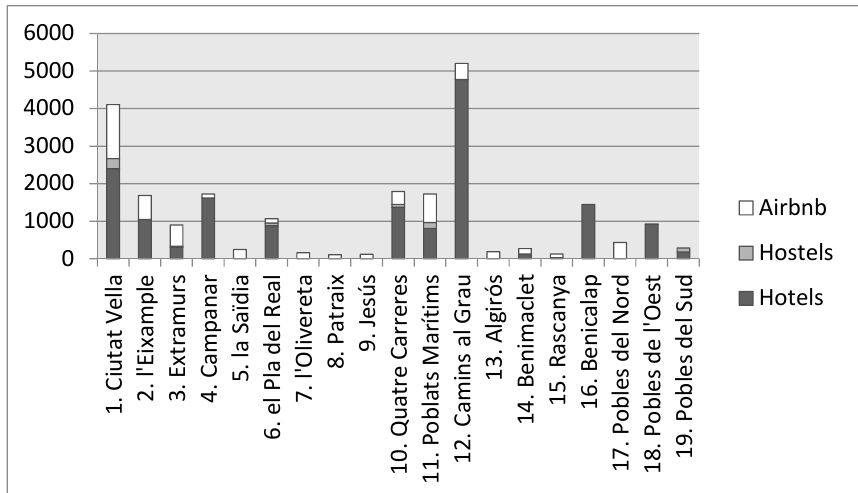
Figure 4. Evolution in tourist demand in Valencia in hotels and tourist apartments. Source: [24].